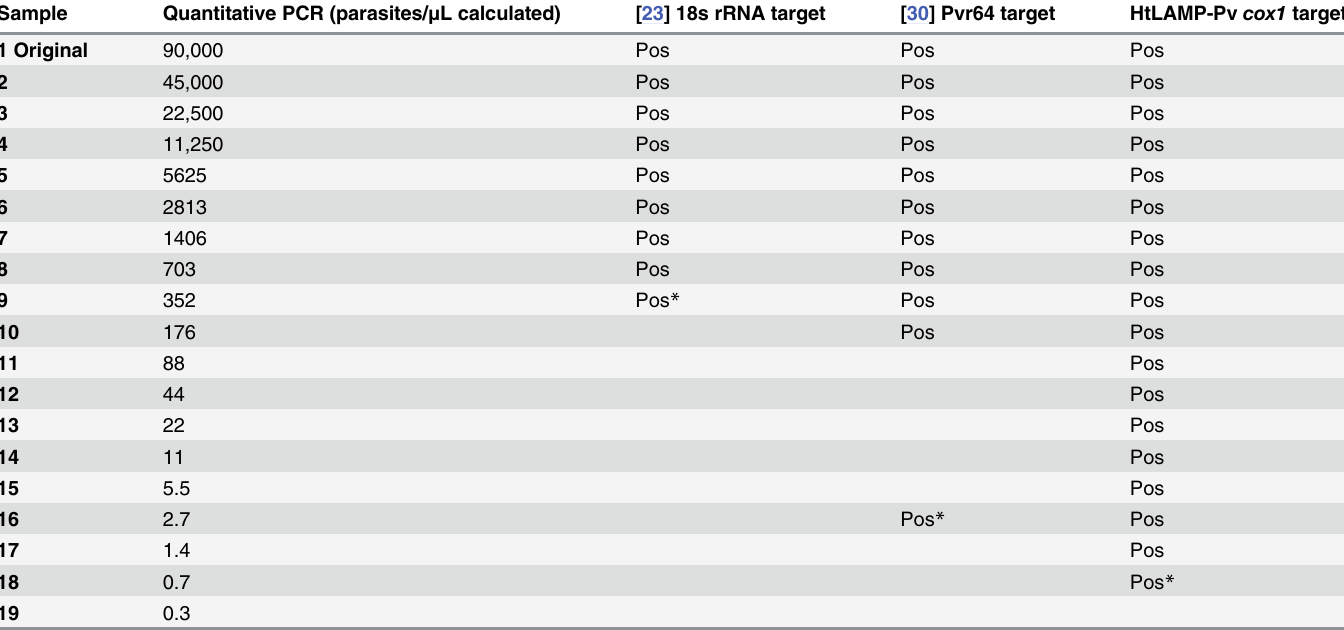
Table 3. Analytical sensitivity of HtLAMP-Pv, compared with other published P . vivax LAMP primers, using a DNA dilution series of clinical sample with qPCR confirmed parasitemia. Each sample was tested in duplicate in the HtLAMP platform using each of the three P . vivax LAMP primer sets. The dilution at which both duplicates were positive was the limit of detection for each of the primer sets in the HtLAMP platform (Pos * indicates dilutions at which only one of the duplicates was positive). HtLAMP-Pv was able to detect 1.4 parasites/ μ L compared with previously published P . vivax LAMP primers. Sample